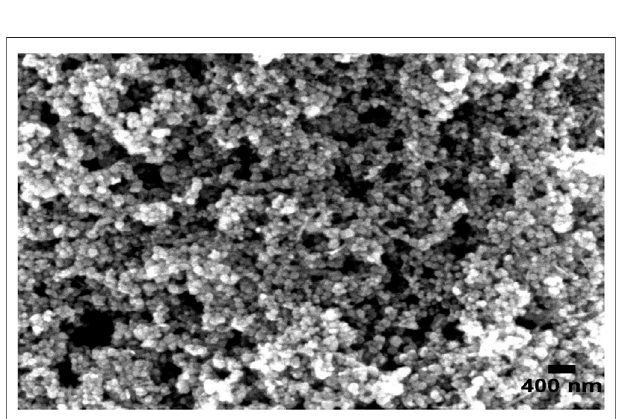
FIGURE 5 | Transmission electron microscope image of Fe – Ag co- doped TiO 2 NPs.